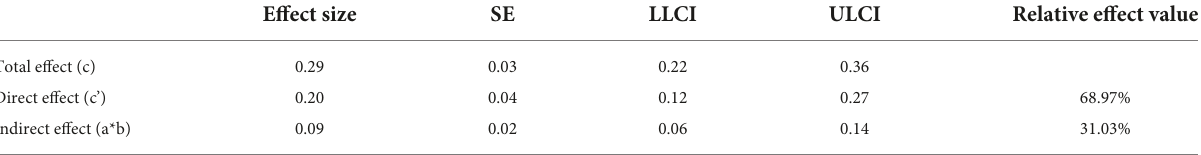
TABLE 6 Direct and indirect effects and 95% confidence intervals for the